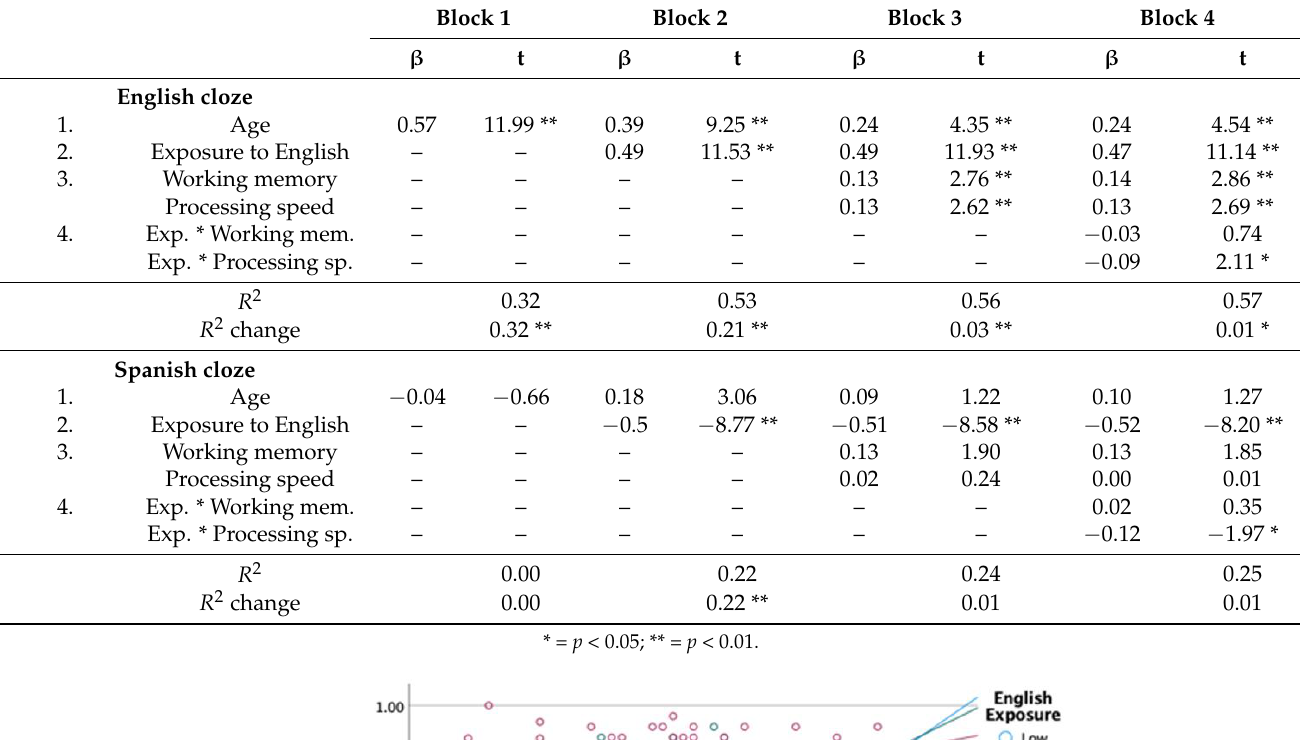
Table 4. Model summaries of regressions predicting morphosyntax using cloze tasks.